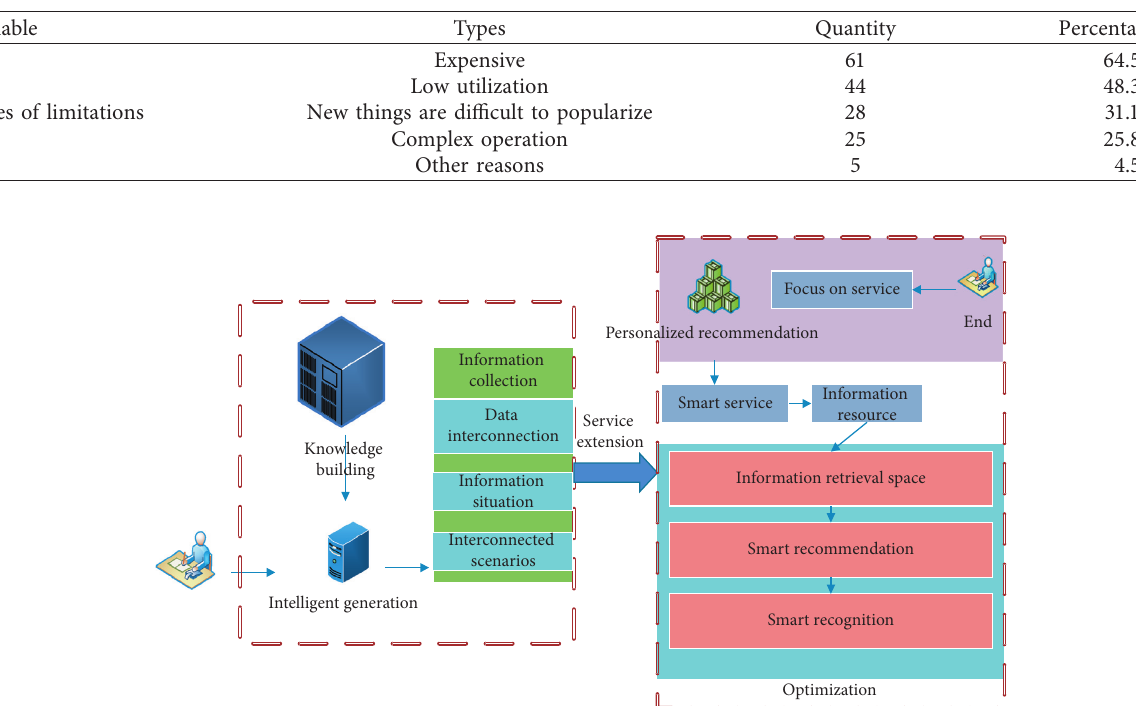
Table 4: Users’ views on